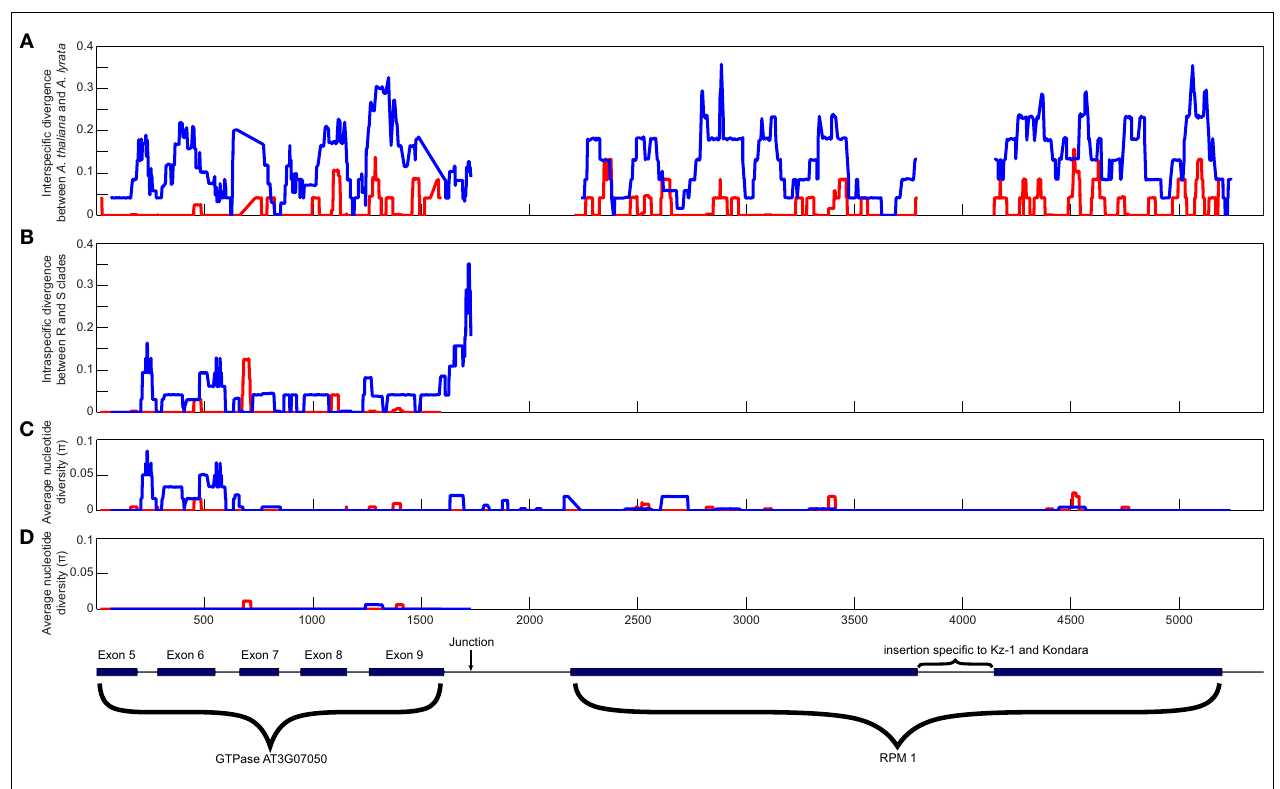
RPM1- deletion null. Silent polymorphisms include both synonymous polymorphisms and polymorphisms in non-coding regions, such as introns. The structure of the genes is shown below the graph. Boxes indicate exons, solid lines indicate introns. Sliding window analyses were conducted using DnaSP v. 5 (Librado and Rozas, 2009).Values are midpoints of 25bp